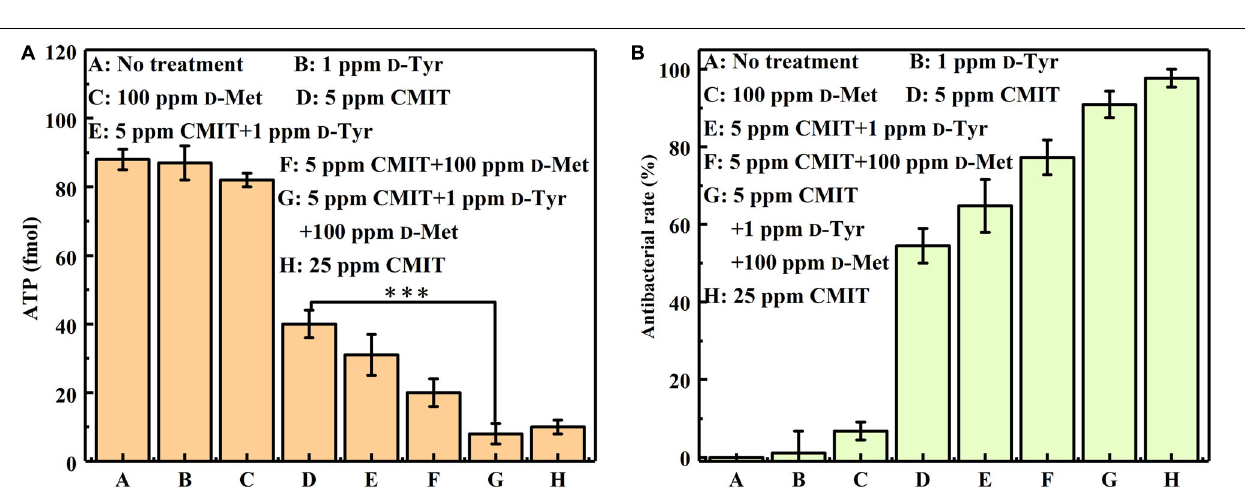
FIGURE 4 | The amount of ATP on the AA2024 coupon surfaces after 3-day biofilm prevention test: (A) ATP and (B) antibacterial rate. Standard deviations were from three independent experiments. *** P < 0.001. There was no significant difference between group G and H ( P > 0.05).